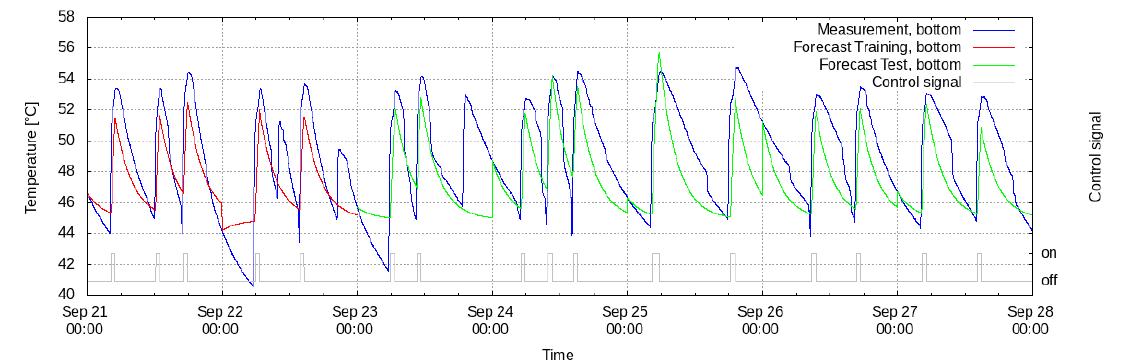
Figure 7. Model of degree one for the heat pump’s lower temperature during the training (red) and the testing (green) period compared to the actual measurements